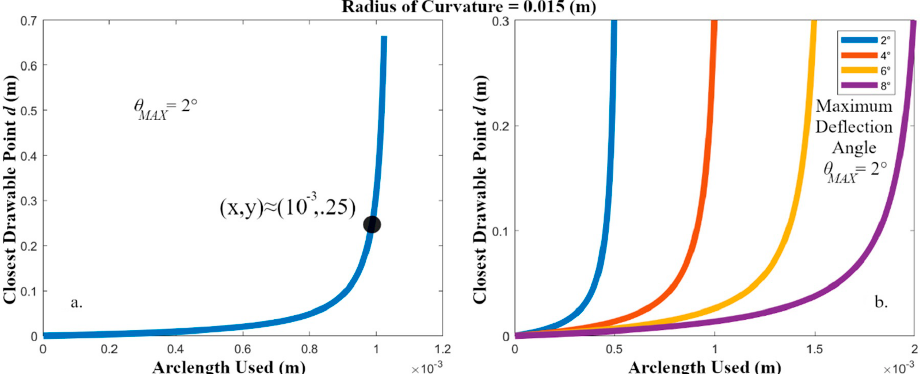
Figure 6. ( a ) As the arclength (2 𝑎 in Figure 7) increases, the ability of the device to focus on a point near the eye is reduced. This eventually reaches a point where, due to the curvature of the device, the 𝜃 (cid:3014)(cid:3002)(cid:3025) = 2° afforded by the device is insufficient to draw any point. ( b ) Here, we consider different deflection angles, 2 ∙ 𝜃 (cid:3014)(cid:3002)(cid:3025) . As expected, increasing the deflection angle allows us to use a larger arclength.